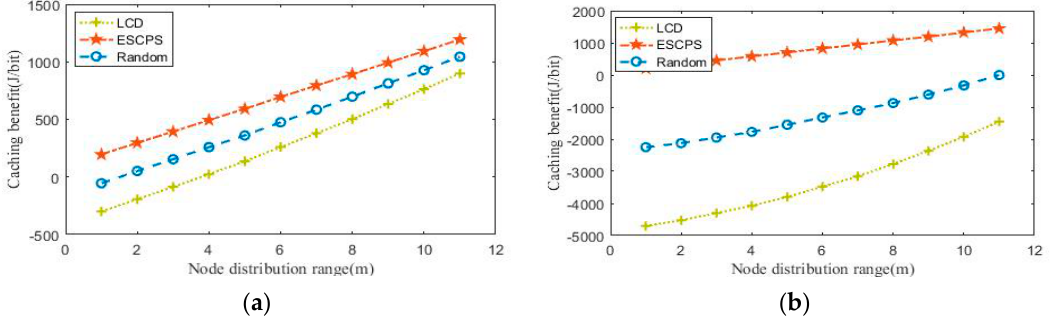
Figure 6. ( a ) The effect of node distribution on the caching benefit ( P c = 0.1); ( b ) the effect of node distribution on the efficiency of caching ( P c = 1).